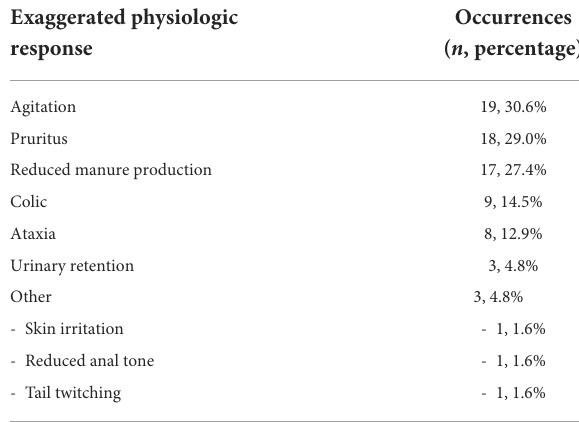
TABLE 2 Exaggerated physiologic responses observed in 62 epidural